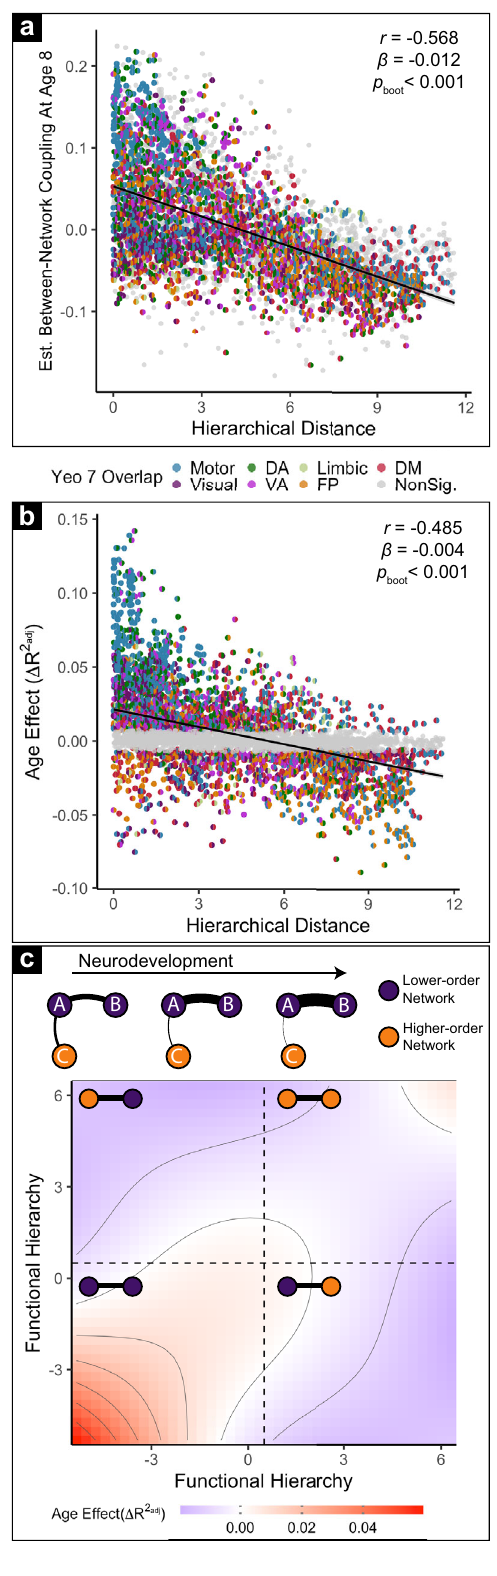
dependency might be just one of many shifts in between- participant variability over scales 32,43 , our results highlight the importance of scale and precision functional mapping techniques for investigations of individual differences in functional network coupling.